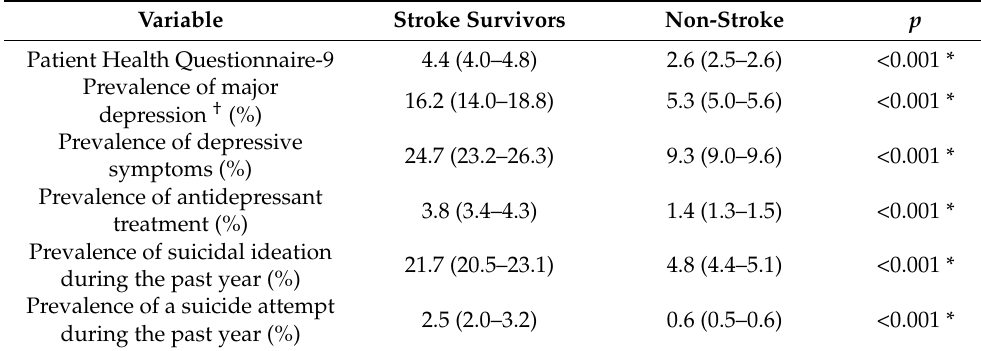
Table 2. Comparison of the participants’ mental health according to their history of